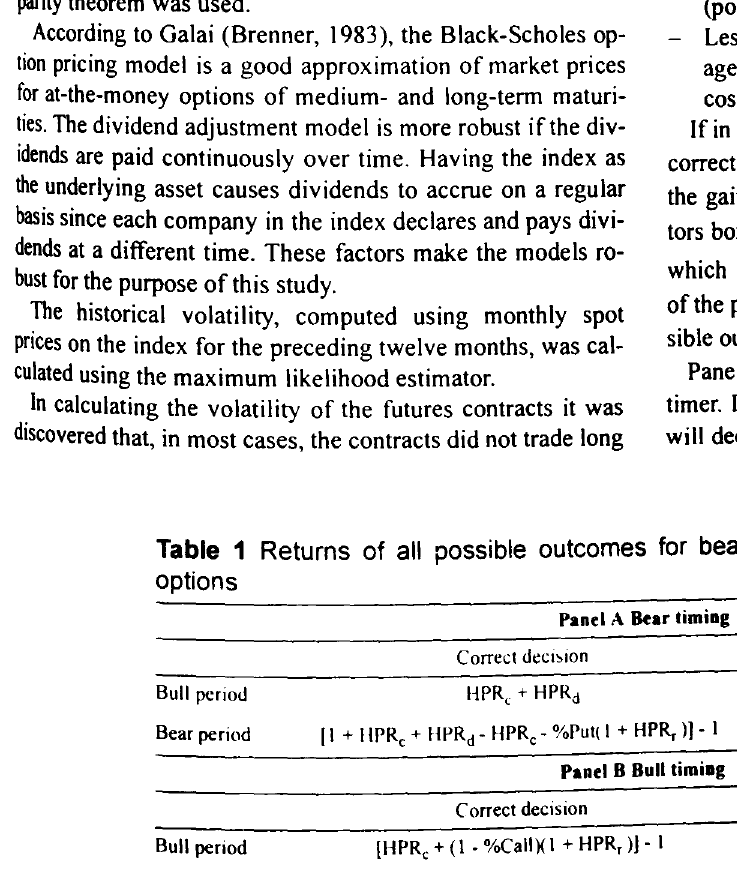
Table 1 Returns of all possible outcomes for bear and bull timing strategies